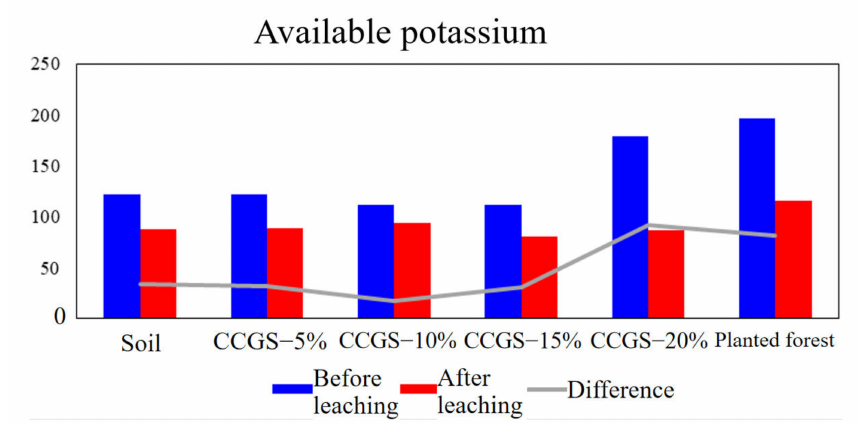
Figure 18. Effect of CCGS on available potassium.